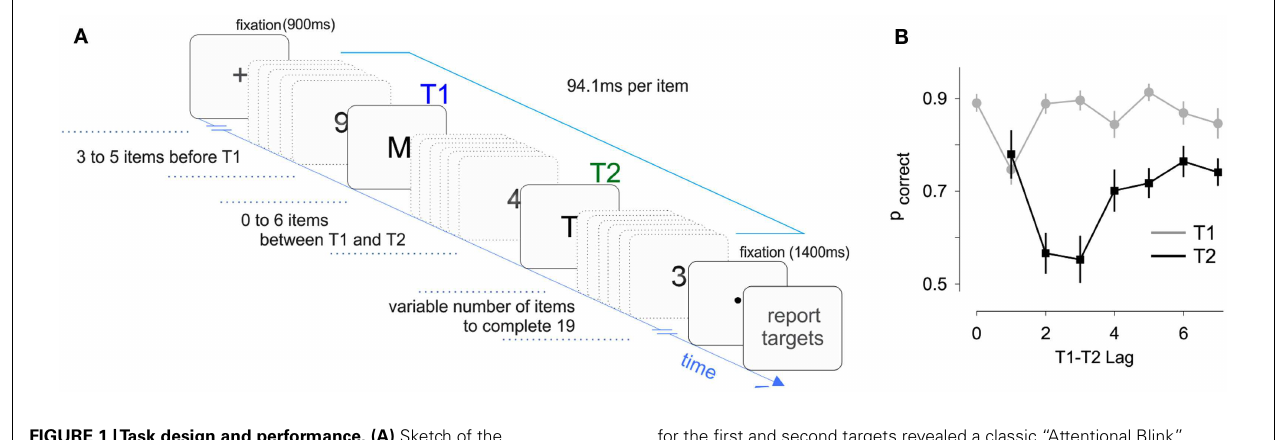
FIGURE 1 |Task design and performance. (A) Sketch of the experiment. Subjects had to report the identity of the letters embedded within a sequence of distracting numbers. Subjects were required to keep fixation both before and after the RVSP. (B) Accuracy